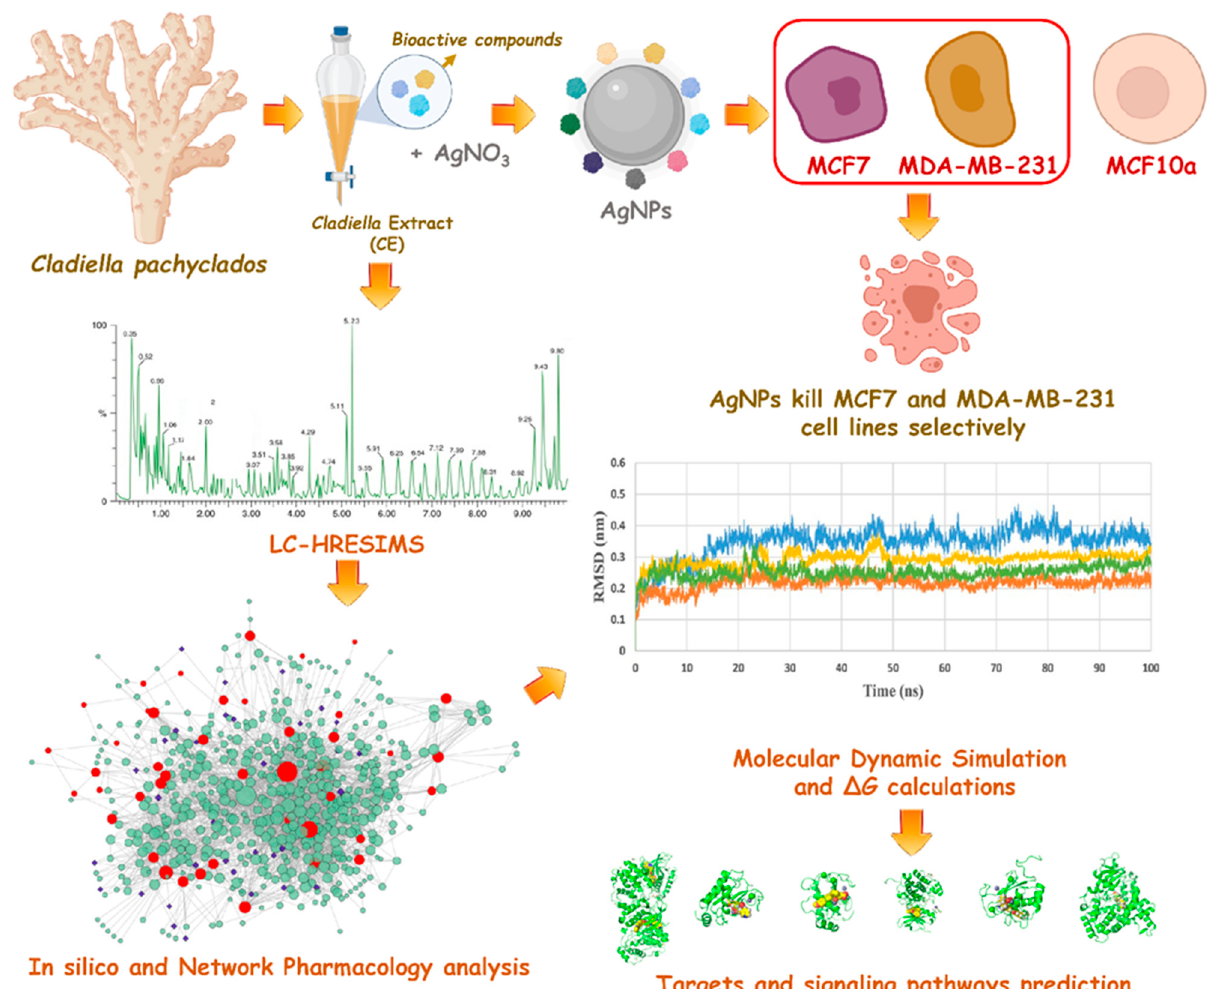
Figure 1. The applied strategy and the main findings of this